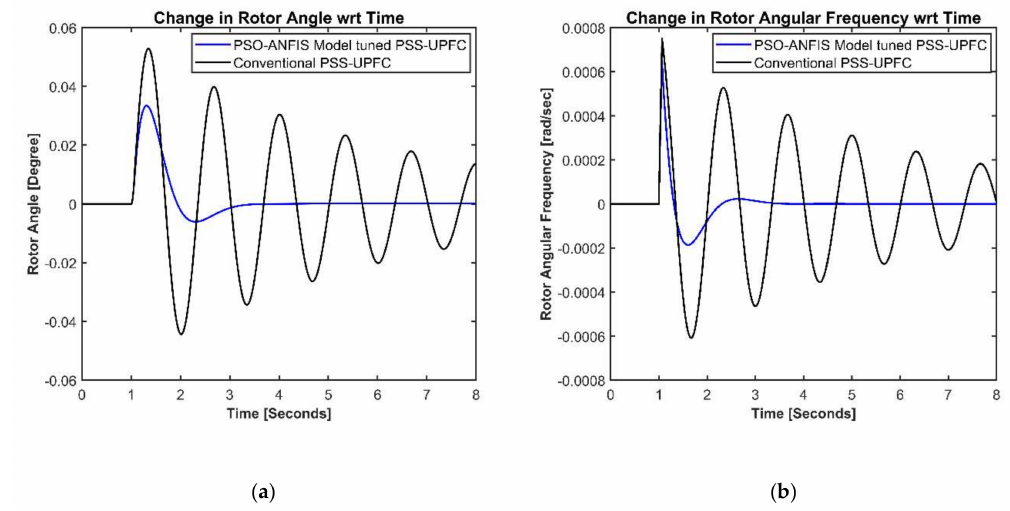
Figure 15. System response for an external disturbance applied at 1.0 s (second network); ( a ) Change in rotor angle and ( b ) Change in rotor angular